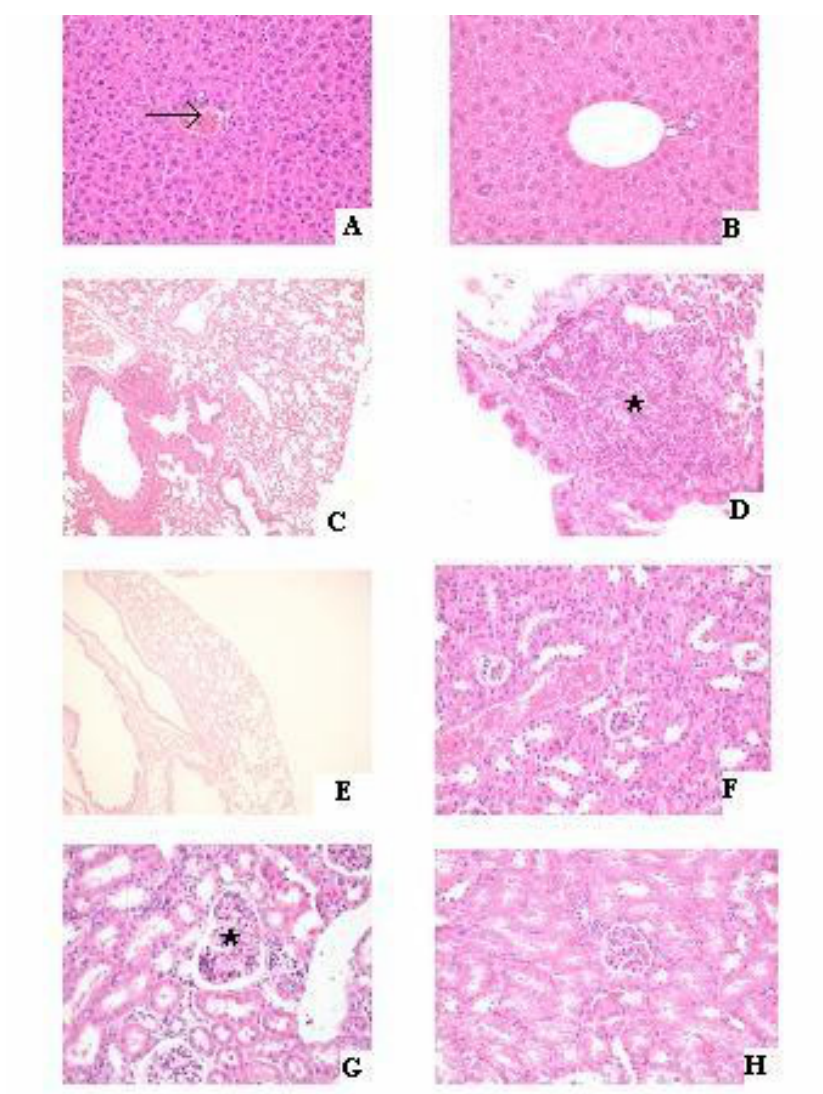
Figure 1. A: Center-lobe vein in the liver of an animal treated with 25 μ g venom (4h); B: Liver of a control animal (4h); C and D: Alveolar spaces and pulmonary alveoli in the lungs of animals treated with 25 μ g venom (4h); E: Lung of a control animal; F and G: Cortical region in the kidneys with glomeruli of animals treated with 50 μ g and 25 μ g venom, respectively (4h); H: Kidney of a control animal (4h). 400X magnification. → : Vascular congestion. ∗ : Inflammatory